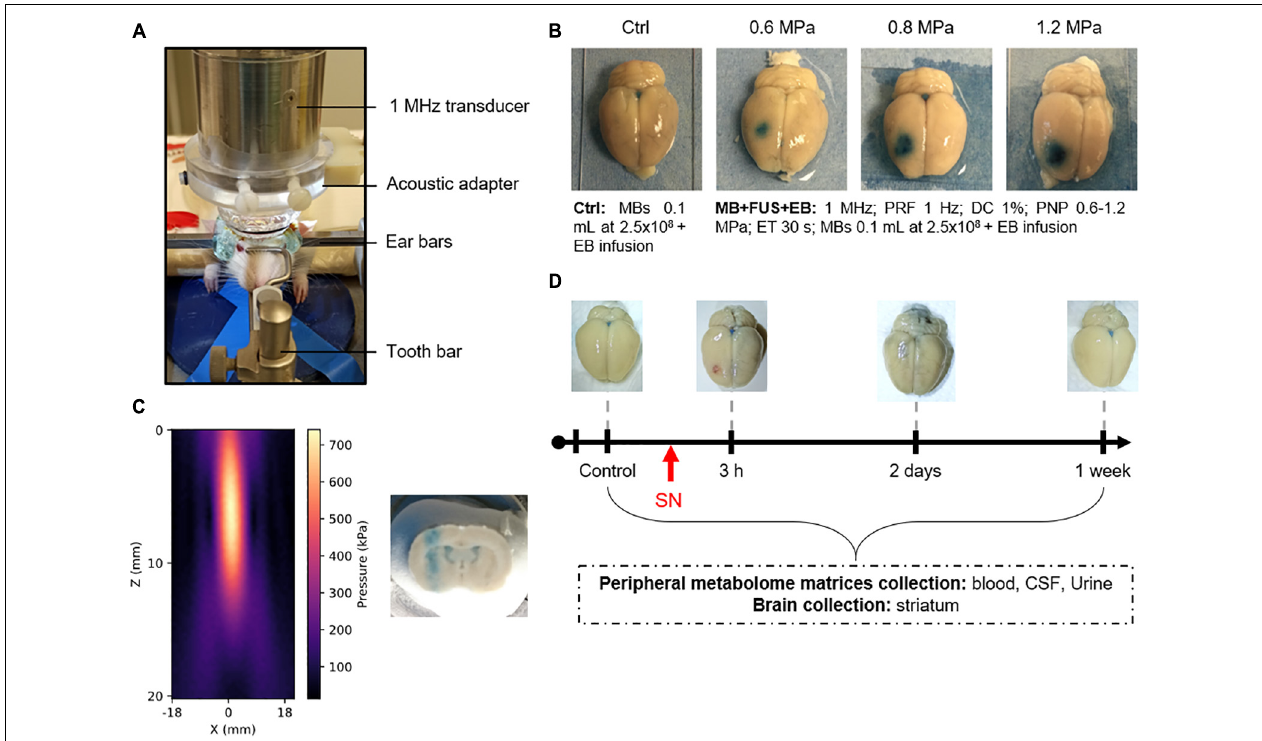
FIGURE 1 | Effects of acoustic pressure on BBB opening (BBBO) without massive hemorrhages and damages. (A) Ultrasound (US) device. (B) Determination of optimal acoustic pressure for BBBO. (C) Ultrasonic beam profile in lateral and depth dimensions of the focal spot in free-gas water. A coronal slice was also cut after Evans Blue dye infusion to visualize the focal spot. (D) Timeline of animal experiments. SN means “sonoporation.”